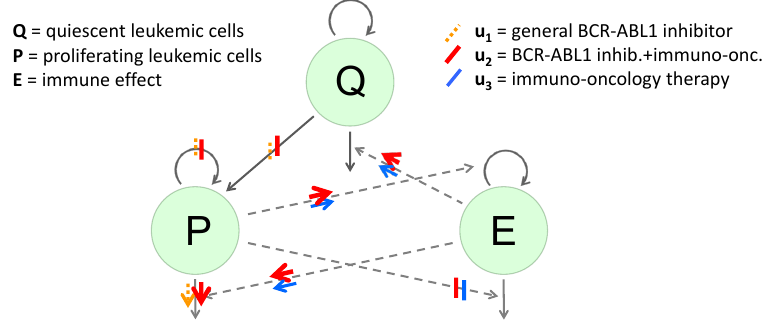
Figure 1. Diagram of the dynamical system. The green circular areas represent the “populations" included in the model. Solid arrows extending from or to the populations represent changes in numbers, with inward-pointing arrows representing increases and outward-pointing arrows decreases. Dashed arrows indicate indirect effects on those increases or decreases. Bars represent inhibition of a production or an indirect effect, due to the represented treatment; arrows represent amplification of a rate or an indirect effect. The effects of the general BCR-ABL1 inhibitor u 1 are shown using orange dashed bars and arrows, the effects of the BCR-ABL1 inhibitor u 2 which also has immune effects are shown using wide red solid bars and arrows and the effects of the immunomodulatory compound u 3 are shown using blue solid bars and